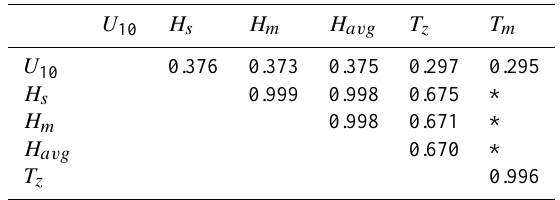
Fig. 8. Wave age ( C/U 10 ) vs. wave steepness ( H s /L ).